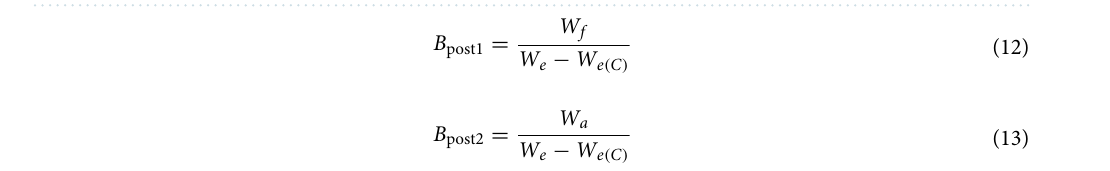
Figure 12. The variation curves of each index under different circumferential pressure and inclination